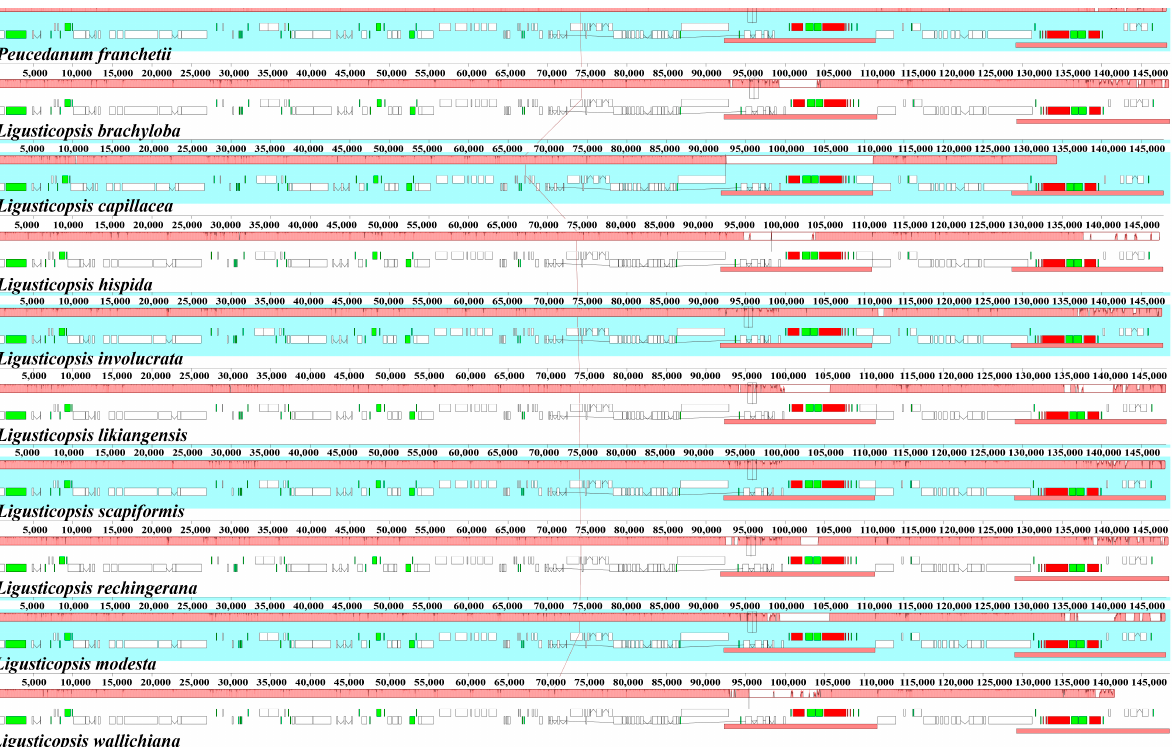
Figure 7. Mauve alignment of ten plastomes. Local collinear blocks within each alignment are represented by blocks of the same color connected with lines.